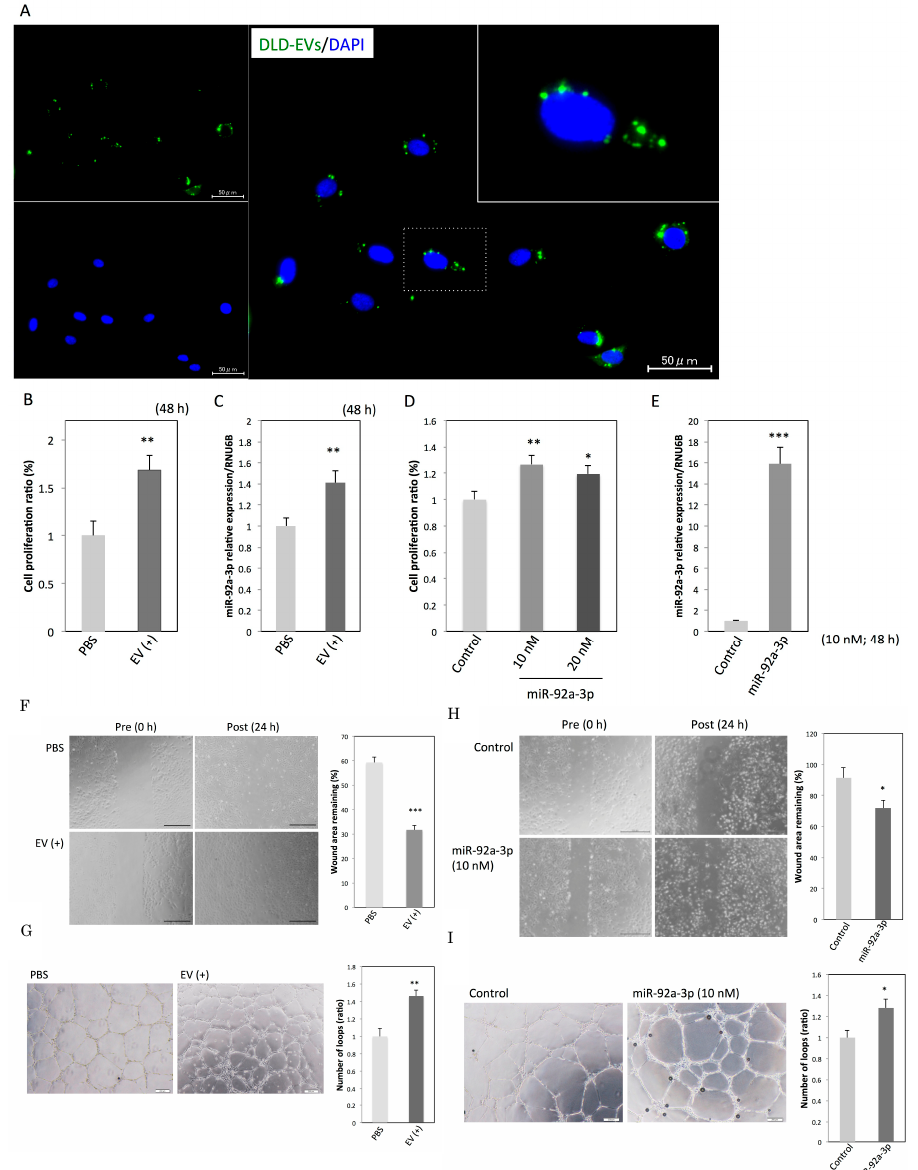
Figure 2. EVs enriched with miR-92a-3p induce a pro-angiogenic state in endothelial cells. ( A ) Immunostaining of human umbilical vein endothelial cells (HUVECs) at 16 h after the incubation with EVs was performed: EVs were derived from DLD-1 cells (green), and nuclei were from HUVECs (blue). Scale bars: 50 µ m. The inset is an enlarged image of a nucleus and EVs. ( B ) Cell proliferation ratio and ( C ) relative expression levels of intracellular miR-92a-3p at 48 h after the incubation of HUVECs with PBS or EVs derived from DLD-1 cells. ** p < 0.01. ( D ) Cell proliferation ratio and ( E ) relative expression levels of intracellular miR-92a-3p at 48 h after the transfection of HUVECs with miR-92a-3p or nonspecific control miRNA. * p < 0.05, ** p < 0.01, and *** p < 0.001. ( F ) Migration assay and ( G ) tube formation assay in HUVECs incubated with PBS or EVs. Scale bars: 500 µ m in Figure 2F and 200 µ m in Figure 2G. ** p < 0.01; *** p < 0.001. ( H ) Migration assay and ( I ) tube formation assay in HUVECs transfected with miR-92a-3p or nonspecific control miRNA. Scale bars: 500 µ m in Figure 2H and 200 µ m in Figure 2I. * p < 0.05. miRNA, microRNA; EV, extracellular vesicle; HUVEC, human umbilical vein endothelial cell; PBS, phosphate bu ff ered